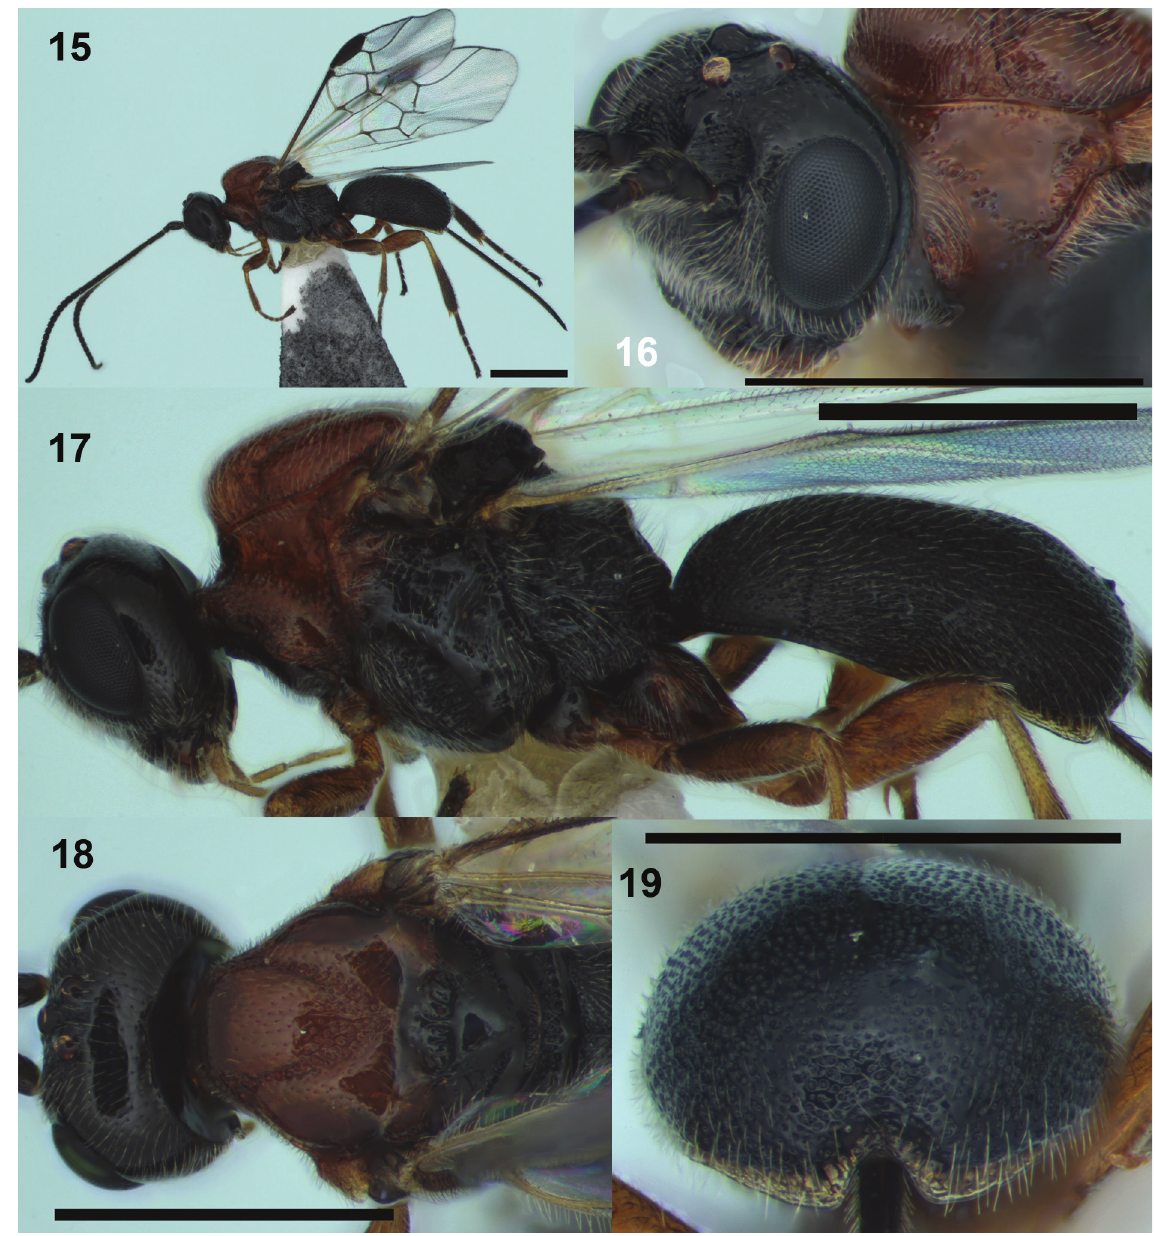
Figs 15–19. Schizoprymnus collaris (Thomson, 1874), ♀ BMNH(E)968229. 15 . Lateral habitus. 16 . head. 17 . Lateral body. 18 . Dorsal head. 19 . Mesosoma, posterior tergite 3. Scale bars all 1 mm. © Natural history Museum,